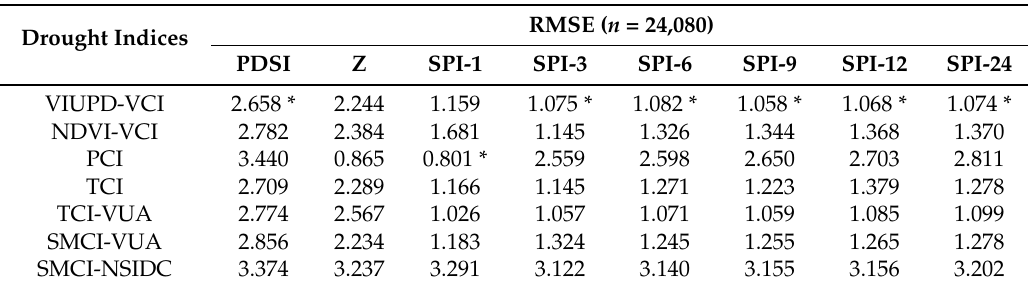
Table 4. Comparisons of RMSE between VIUPD-derived VCI and other commonly used remote sensing-based single drought indices.